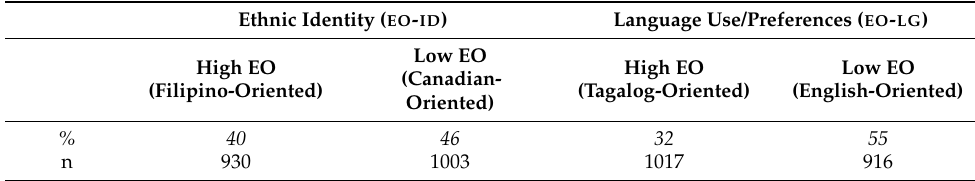
Table 6. Rates of use of the approximant according to ethnic orientation, for heritage speakers (n =